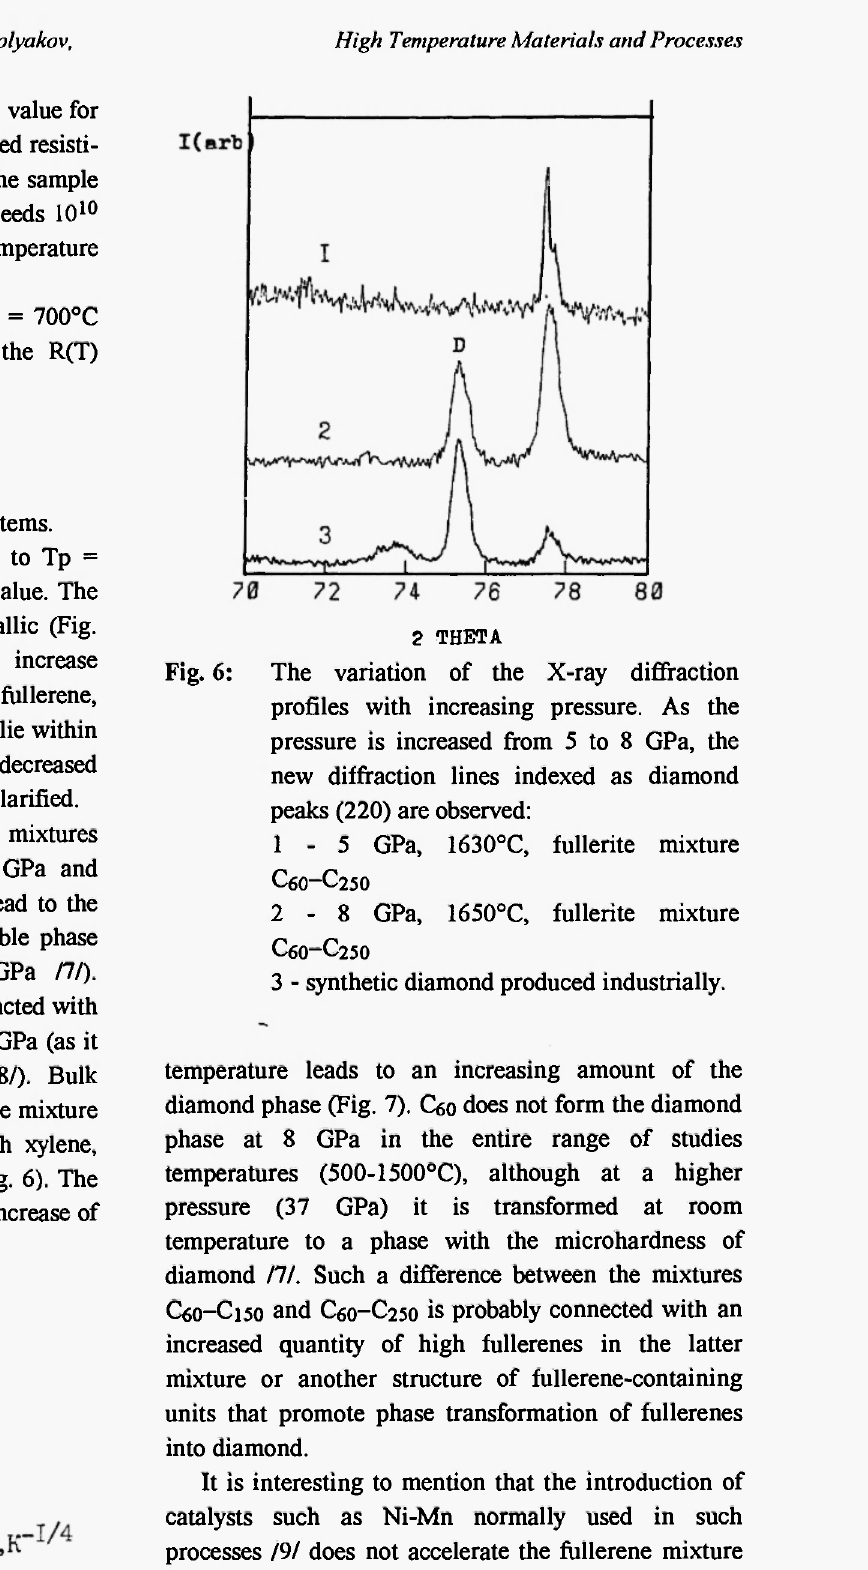
Fig. 5: The temperature dependence of resistivity, R, for Ceo samples heated to 900°C under a pressure of 3 GPa.